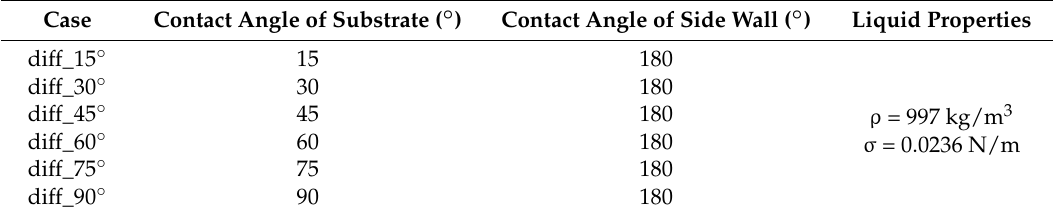
Table 2. Parameters used in the simulation cases under different wetting conditions.